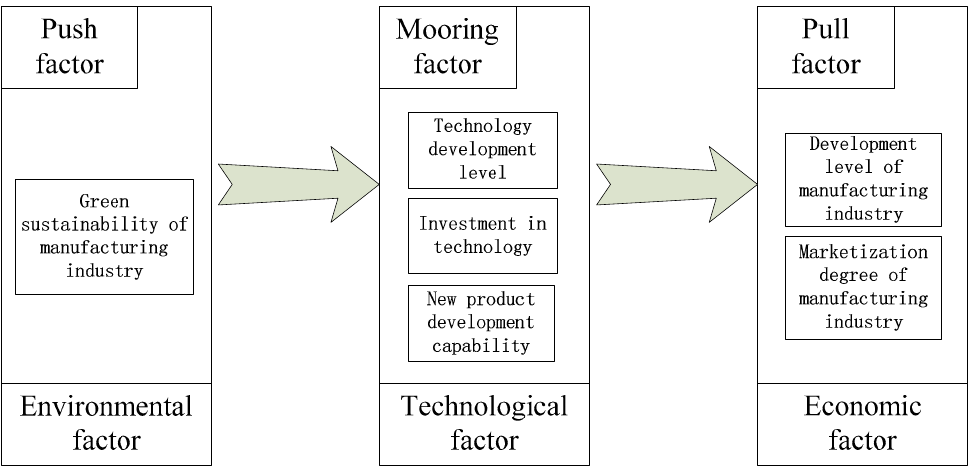
Figure 1. Conceptual framework of a regional advanced manufacturing industry (AMI).